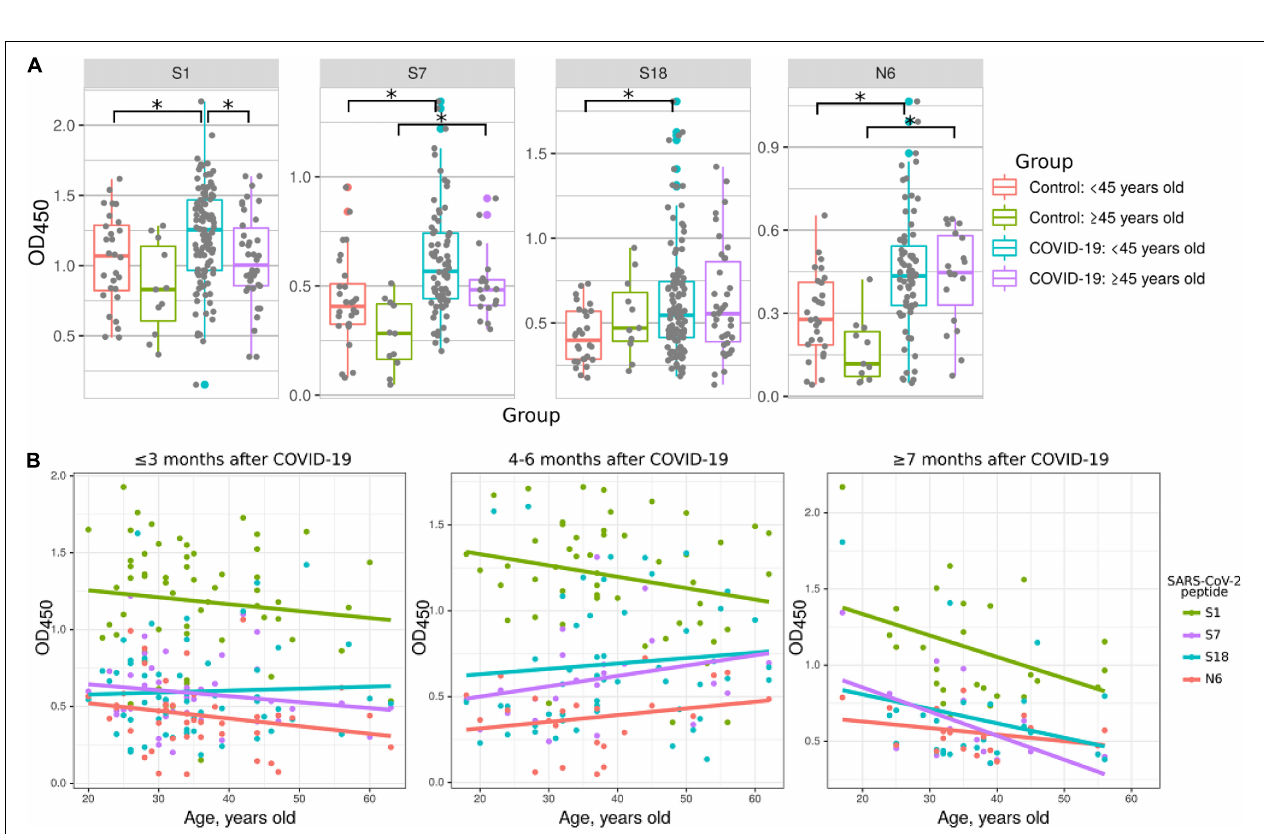
FIGURE 5 | Reactivity of COVID-19 serum to SARS-CoV-2 peptides depending on age of patients. Patients were divided into young ( < 45 years old) and old ( ≥ 45 years old) groups. Antibody reactivity was analyzed using ELISA. Peptides were adsorbed on a 384-well plate and probed with serum samples. Only reactivity to peptides which significantly differed from that in corresponding age control is presented. (A) Age groups dependent difference to SARS-CoV-2 peptides reactivity in COVID-19 serum. Asterisks indicate statistically significant differences between reactivity to SARS-CoV-2 peptides depending on age of the patient ( p < 0.05, Kruskal-Wallis test with Benjamini-Hochberg adjustment). (B) Age based distribution of reactivity to SARS-CoV-2 peptides in COVID-19 patient serum. Colored lines – linear regression of OD450 value.